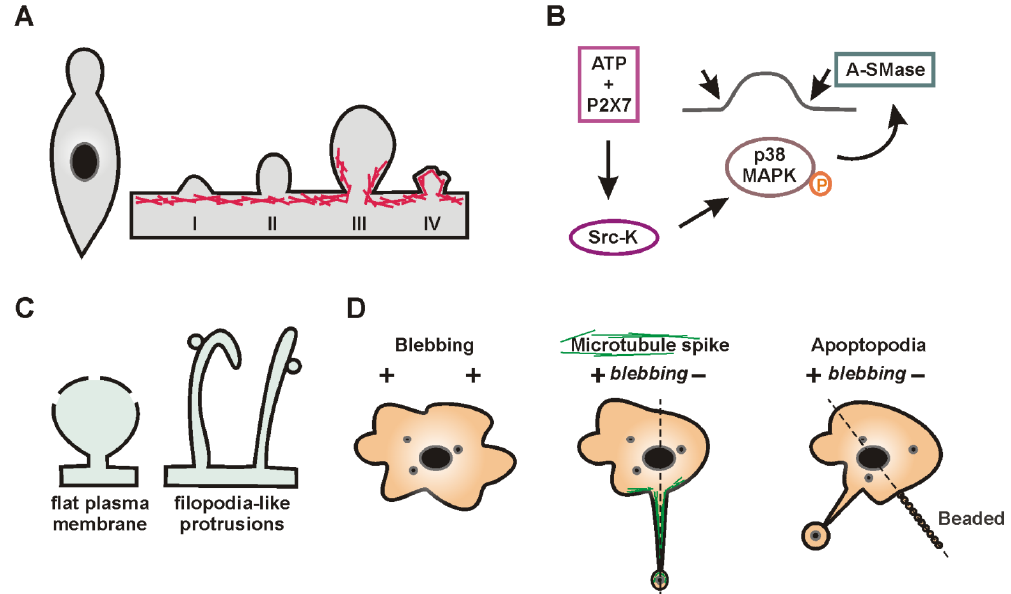
Figure 4. The formation of blebs and similar structures on the plasma membrane. ( A ) A characteristic feature of the amoeboid movement is the formation of a bleb lacking the actin cortex (I) [191]. Its size expands according to the influx of the cytoplasm (II). The bleb growth stops when the actin cytoskeleton (red lines, III) reassembles. Eventually, the bleb retracts into the plasma membrane (IV). ( B ) Receptor-induced biogenesis of microvesicles. Stimulation of the P2X7 receptor by ATP results in the phosphorylation of P38 MAP kinase (p38 MAPK) by src-protein tyrosine kinase (Src-K). Phosphorylation of P38 promotes the translocation of acid sphingomyelinase (A-SMase) to the outer lea fl et of the plasma membrane, where it triggers ceramide-dependent microvesicle biogenesis [197]. ( C ) Vesicle shedding is a form of the plasma membrane repair mechanism [193]. Annexins have a high a ffi nity for PS and play a key role in the removal of injured membrane regions. Annexin A7 (ANXA7) interacts with the ALG-2 (apoptosis linked gene-2) protein, which is a partner of ALIX. In turn, the ESCRT-III complex is assembled through ALIX and provides the damage site shedding [134,193]. In some cases, the vesicularization is preceded by the formation of fi lopodia-like protrusions at the damage site [195]. ( D ) Formation of apoptotic bodies [205]. Microtubule-rich membrane protrusions (microtubule spikes) and beaded apoptopodia can be formed in the presence or absence of membrane blebbing. Thin, string-like apoptopodia are generated between membrane blebs.